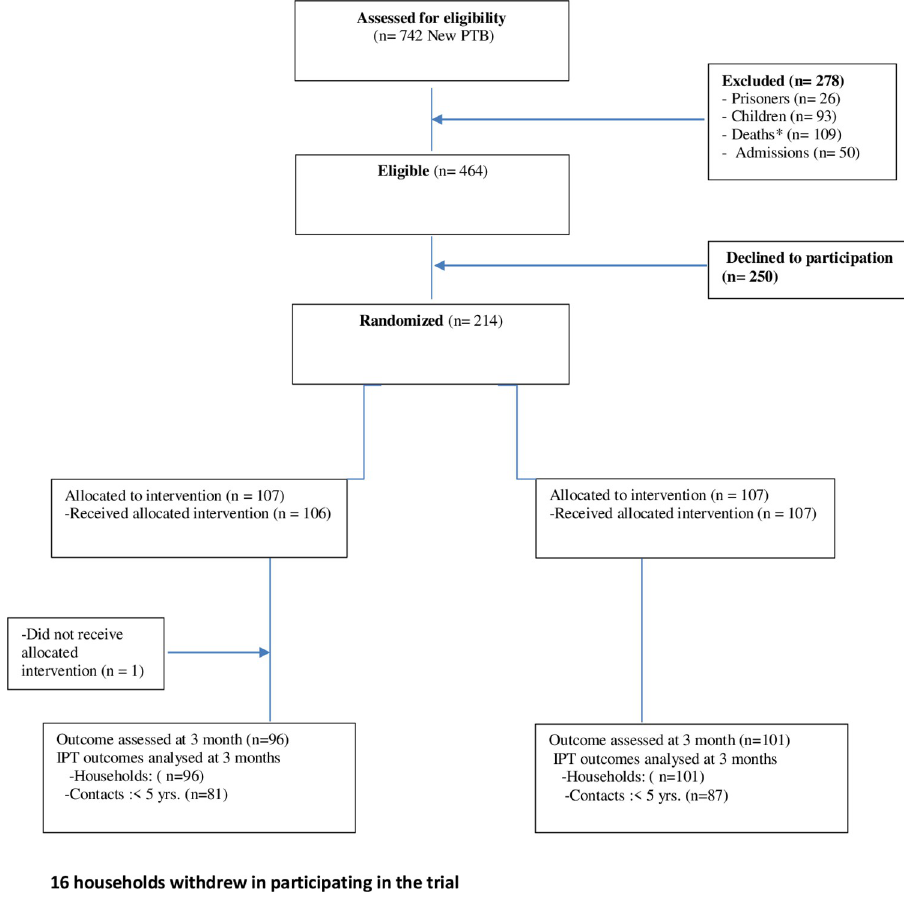
Fig 1. Trial flow